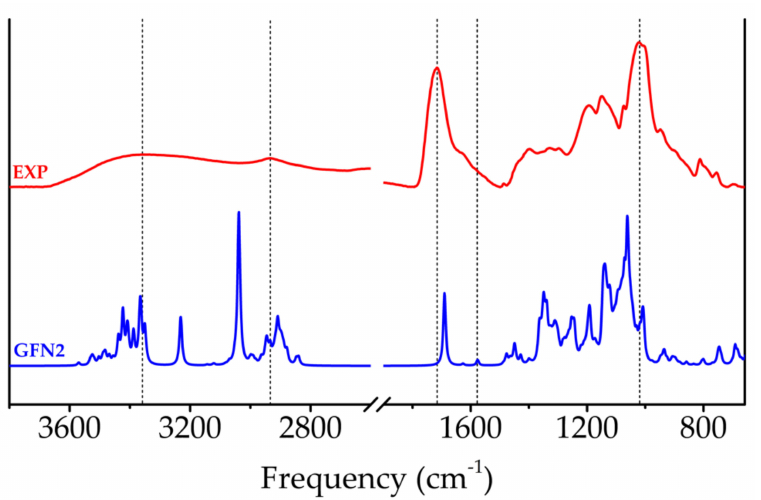
Figure 9. Experimental (red line) vs. GFN2-computed (blue line) spectra of the most stable inclusion complex (MT- β